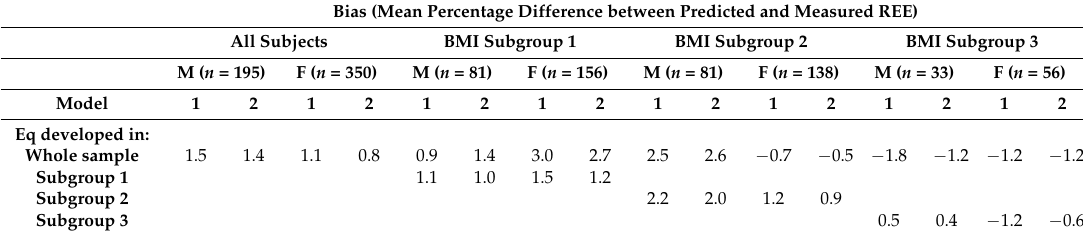
Table 5. Bias (mean percentage error between predicted and measured REE) for the new predictive equations in the entire study groups as well as BMI subgroups. Bias (Mean Percentage Difference between Predicted and Measured REE) All Subjects BMI Subgroup 1